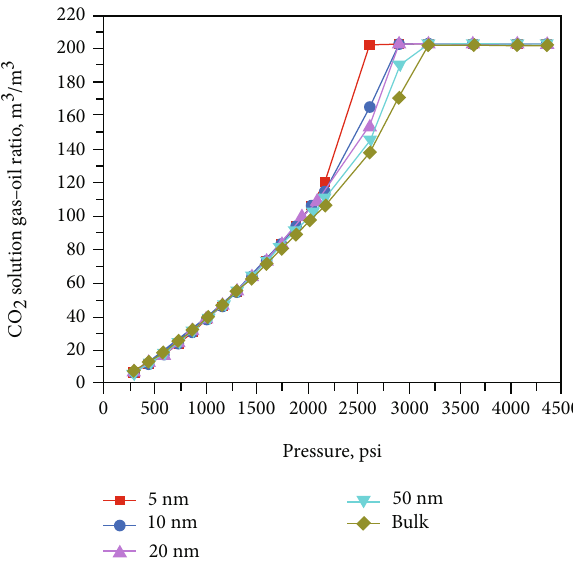
Figure 11: CO solution gas-oil ratio of the Bakken tight oil versus 2 pressure at various pore radii at T = 230 ° F.